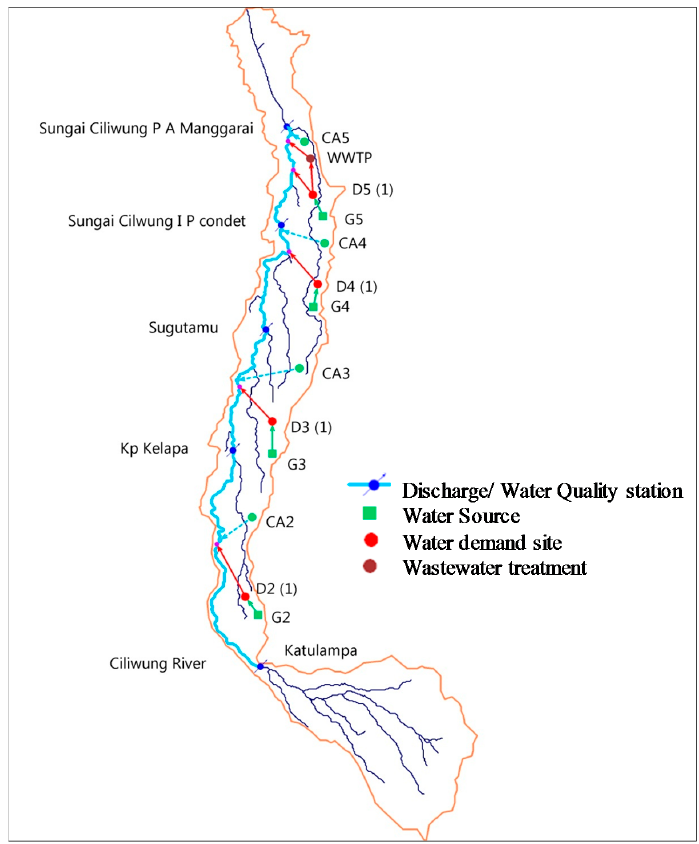
Figure 4. A schematic diagram showing the problem domain for water quality modeling in